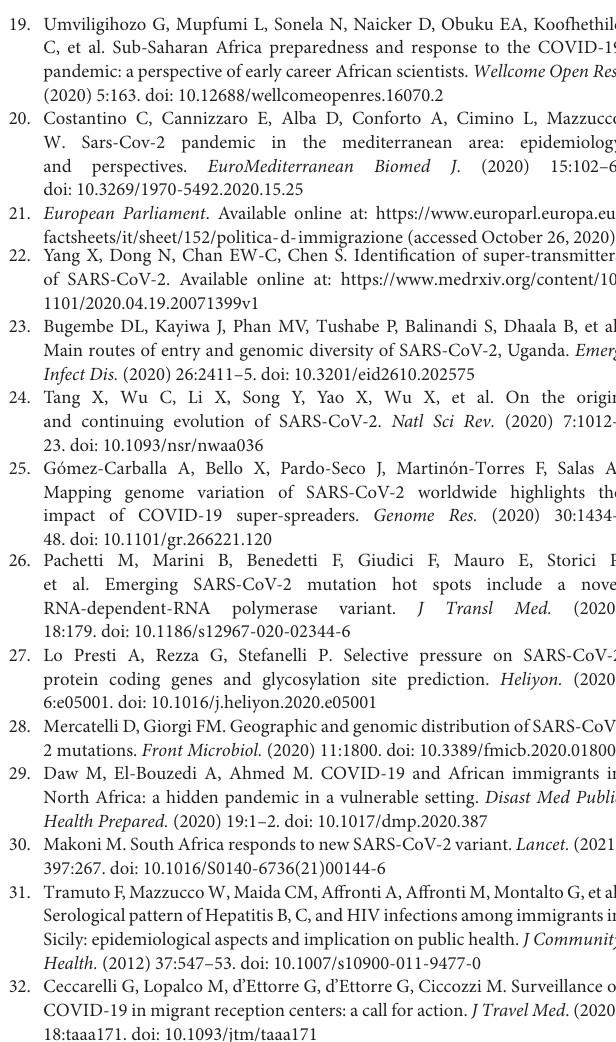
Supplementary Figure 2 | Maximum likelihood phylogenetic analysis of 18 SARS-CoV-2 genomes from migrants (reported in red) and 262 SARS-CoV-2 complete genomes from different countries, retrieved from GISAID and GenBank